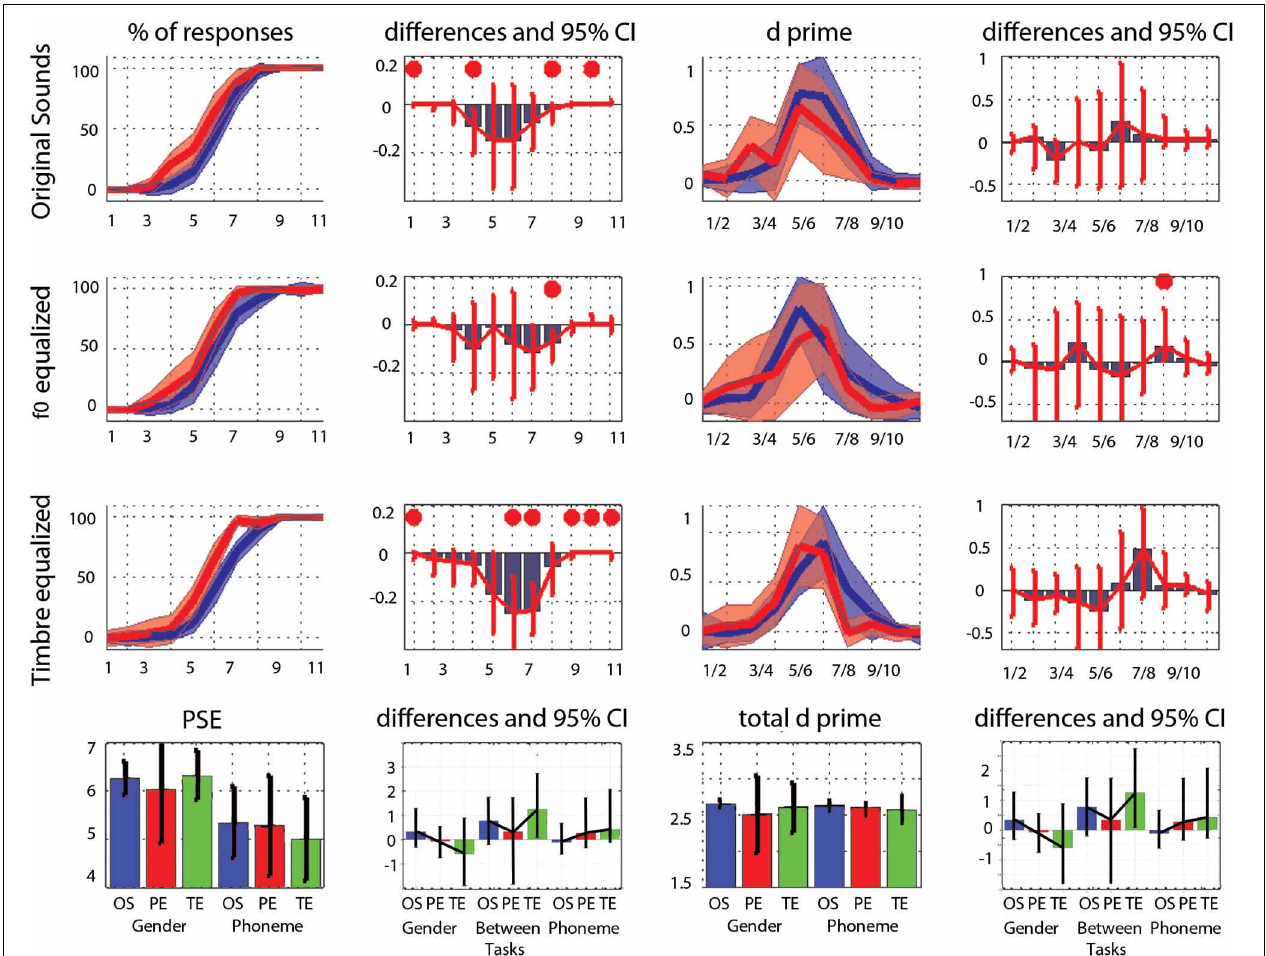
FIGURE 2 | Trimmed mean responses between tasks and per condition. For the first three rows, from left to right are displayed: (i) the 95% CI of response curves in the gender task (blue, percentage of female responses) and in the phoneme task (red, percentage of /ta/ responses), (ii) the differences between tasks in percentage of responses computed for each step (significant differences with adjustment for multiple comparisons marked by a red dot), (iii) the 95% CI of the d’